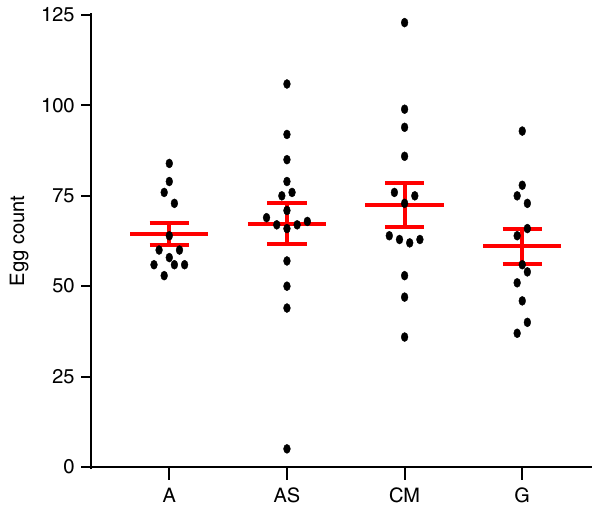
Fig. 6 Egg clutch size. The number of eggs per mosquito is shown for axenic (A; n = 12), axenic supplemented with heat-killed E. coli (AS; n = 15), gnotobiotic (G; n = 12), and colony microbiome (CM; n = 14) mosquitoes. Points represent clutch size for individual females. Mean clutch size and standard error of all individuals are signi fi ed by the red bars. No signi fi cant differences between the groups was detected using a one-way analysis of variance with a P -value cutoff of